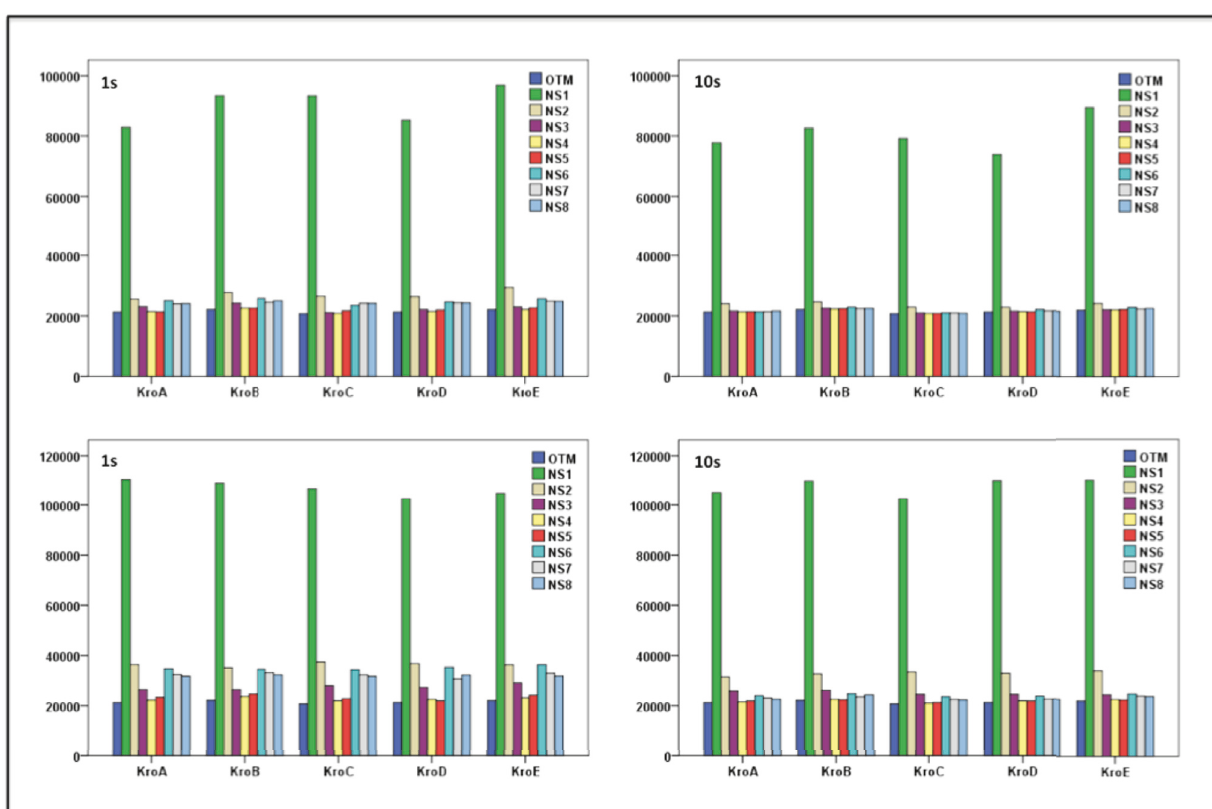
Figure 4: Results of SA and